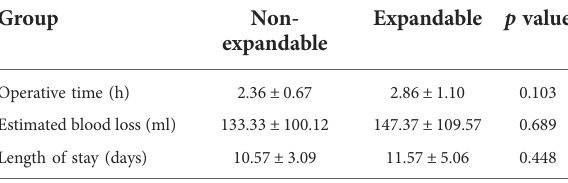
TABLE 2 Comparison of the general situation of operation between patients instrumented with EXP-IFC and